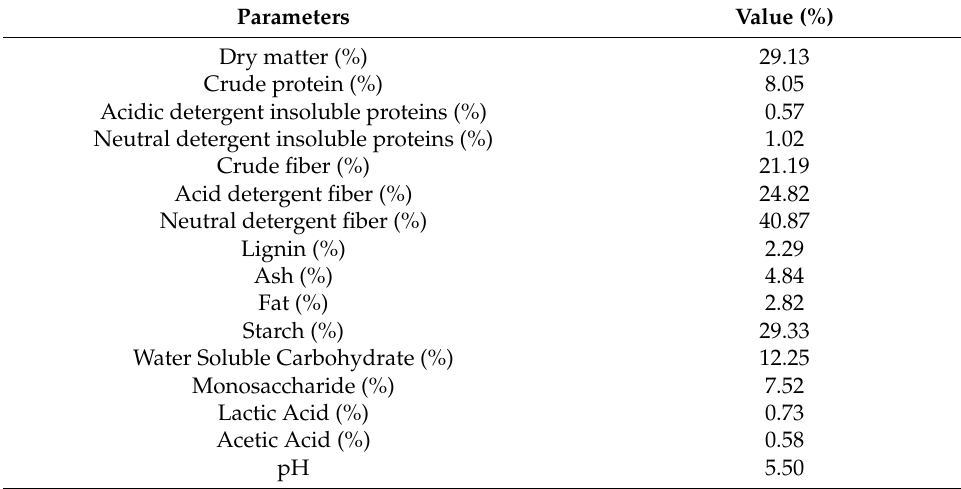
Table 1. Nutritional composition of whole-plant corn